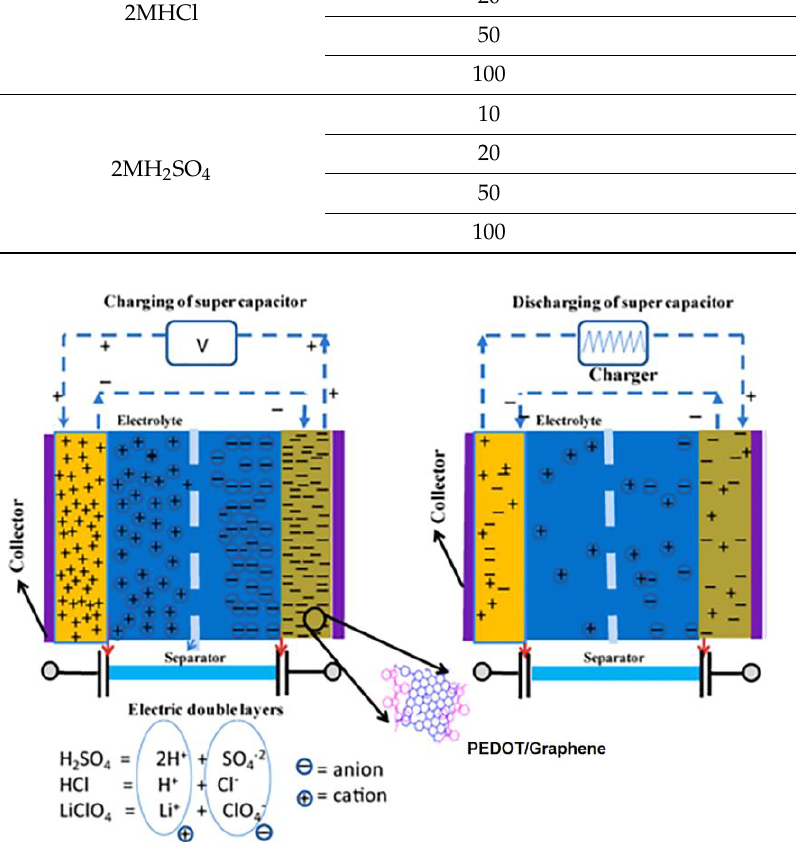
Figure 2. Graphical representation of an electrochemical double-layer-type capacitor with charged ( left ) and discharged ( right ) statuses [67]. Reproduced with permission from Elsevier.